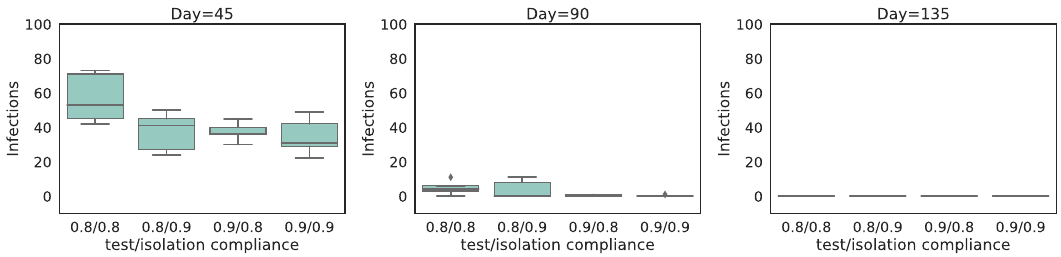
Fig 7. Distribution of the number of infections for the experiments when the lock-down restrictions are continued. We show different scenarios of compliance for testing and isolation. We show the number of infections at three different time points. i.e., 45 days (left panel), 90 days (middle panel) and 135 days (right panel) after the start of the universal testing procedure. These results consider a weekly universal testing procedure (i.e., k = 32 and T d = 50000) and a FNR PCR = 0.1, where the isolation strategy is individual isolation. Each box represents a combination of test and isolation compliance. Note that 135 days after the start of the universal testing procedure (not shown in this figure), the number of cases dropped to zero, for all the compliance